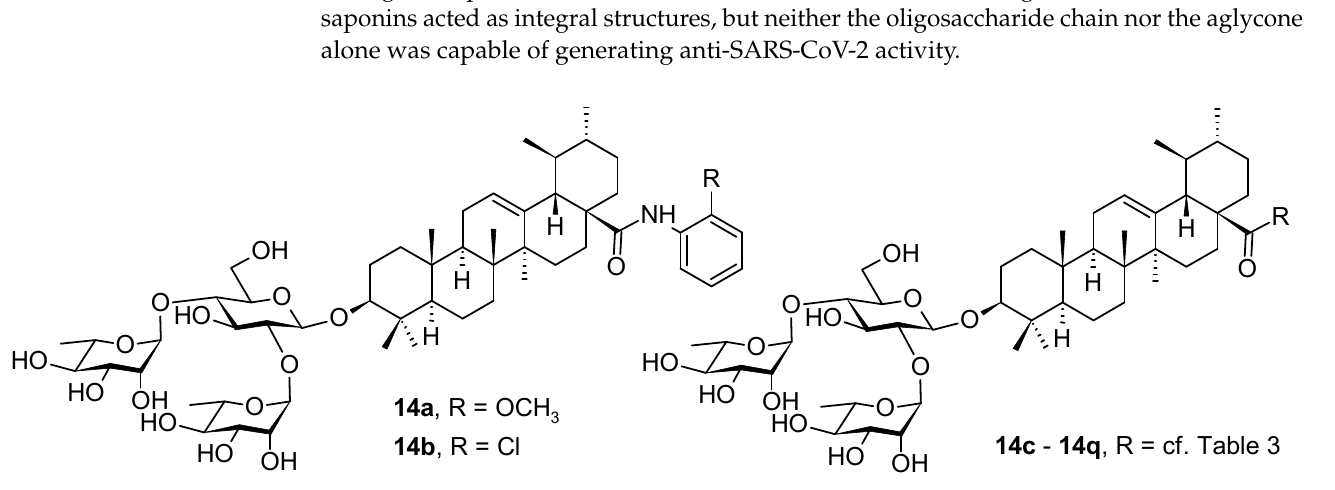
Figure 14. Ursane-type saponin derivatives for the SARS-CoV-2 treatment. To investigate the effect of different substituents in different locations of the basic structure of the triterpenoid molecule, a series of the title saponins 14c – 14q (Figure 14) were designed and synthesized. Based on the antiviral effect of 14a (EC 50 = 10.69 µ M), the inhibition rates of the title saponins against SARS-CoV-2 at the concentrations of c = 40 µ M (high concentration) and c = 10 µ M (low concentration; EC 50 values) were evaluated. The incorporated trifluoromethoxy group as a bioisostere of the methoxy group might form an additional potential interaction with the S protein. The trifluoromethoxy group was first incorporated at the ortho -position of the phenyl ring to generate 14c ; however, the novel compound displayed higher cytotoxicity than 14a (Table 3). The impact of 2,6-disubstitution was determined with 14d . This structural modification resulted in a slight improvement in biological activity, comparable with that of 14a , and the increased antiviral activity was not accompanied by cytotoxicity, as followed from the CC 50 value of the concentration of c > 100 µ M against HEK293T human-ACE2 cells with 14d . In contrast, a replacement of the phenyl ring of 14a with a 2,3-dihydrobenzo[ b ][1,4]dioxine residue ( 14e ) had a negative effect on the antiviral activity. A replacement of the phenyl group by more sterically hindered biphenyl moieties ( 14f – 14h ) resulted in a loss of biological activity. The compound 14i , bearing a quinolone ring with a similar steric hindrance of the substituent, showed surprisingly analogous inhibition activity as 14a . A similar increase in inhibitory potency was also observed with other (6 + 5)-fused heteroaryl derivatives containing the nitrogen group ( 14k was more potent than 14a in cellular assays). These results revealed that larger substituents at the C(28)-position of the ursolic acid ( 1b ; Figure 1) were unfavorable substituents, and finally directed the investigation towards smaller substituents. However, attempts to lower steric hindrance by substituting the phenyl side chain with a small tetrazole group ( 14l ) induced strong toxicity towards HEK293T human-ACE2 cells. The length of the alkyl spacer between the amide group and the phenyl ring affected the inhibition effects of the compounds as well ( 14m – 14o ) [72].